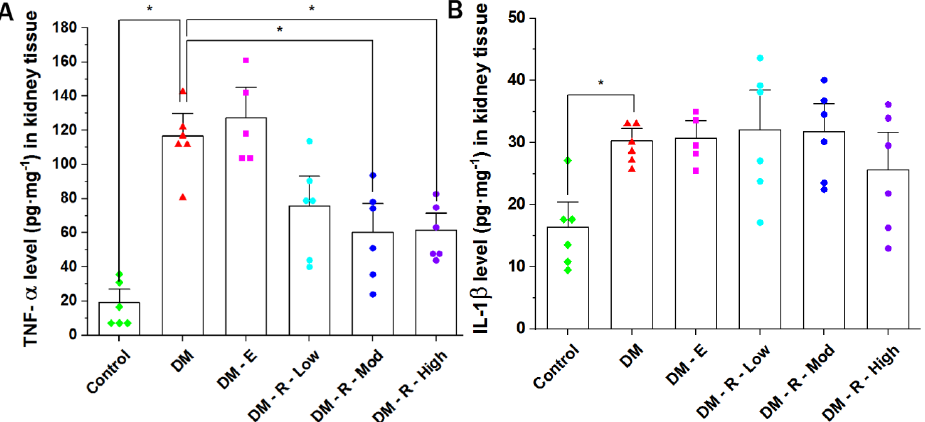
Figure 3. Effect of ruxolitinib on the kidney ( A ) TNF- α and ( B ) IL-1 β levels. ( A ) TNF- α level in kidney tissue homogenates of normal (control) rats and ( B ) IL-1 β level in kidney tissue homogenates of normal (control) and diabetic treated and non- treated male Wistar rats. DM, diabetic non-treated group, DM-E, diabetic enalapril-treated group (10 mg · kg − 1 ), DM-R-Low, diabetic ruxolitinib-treated low-dose group (0.44 mg · kg − 1 ), DM-R-Mod, diabetic ruxolitinib-treated moderate-dose group (2.2 mg · kg − 1 ), DM-R-High, diabetic ruxolitinib-treated high-dose group (4.4 mg · kg − 1 ). Each column represents the mean ( ± S.E.M.) for 6 male Wistar rats. Data are represented as individual values for each mouse (dots). Statistical significance is shown by asterisks (* p < 0.05). The difference among groups was assessed by the Kruskal–Wallis test followed by the Mann–Whitney U test for post hoc group binary